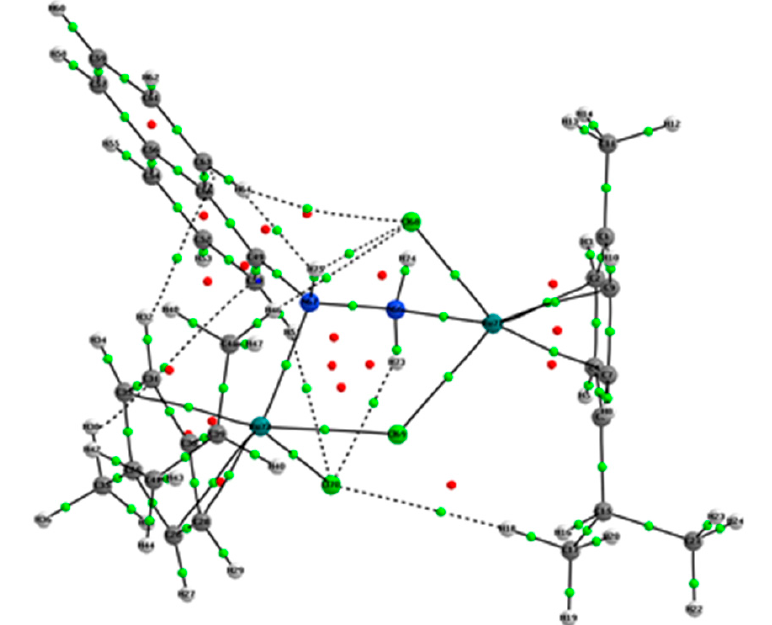
Figure 5. Molecular graph of 2a , dashed lines indicate bond paths, small green, and red points refer to the bond critical points and ring critical points.